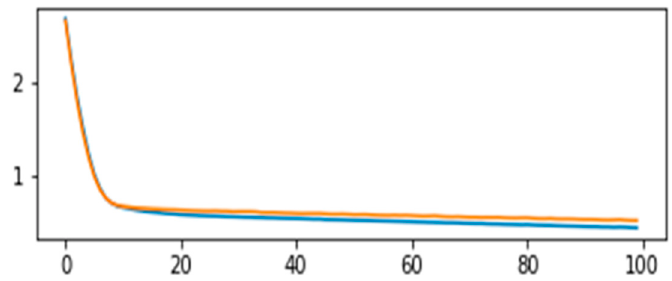
Figure 8. Training and validation loss for the emotion and aura modules.